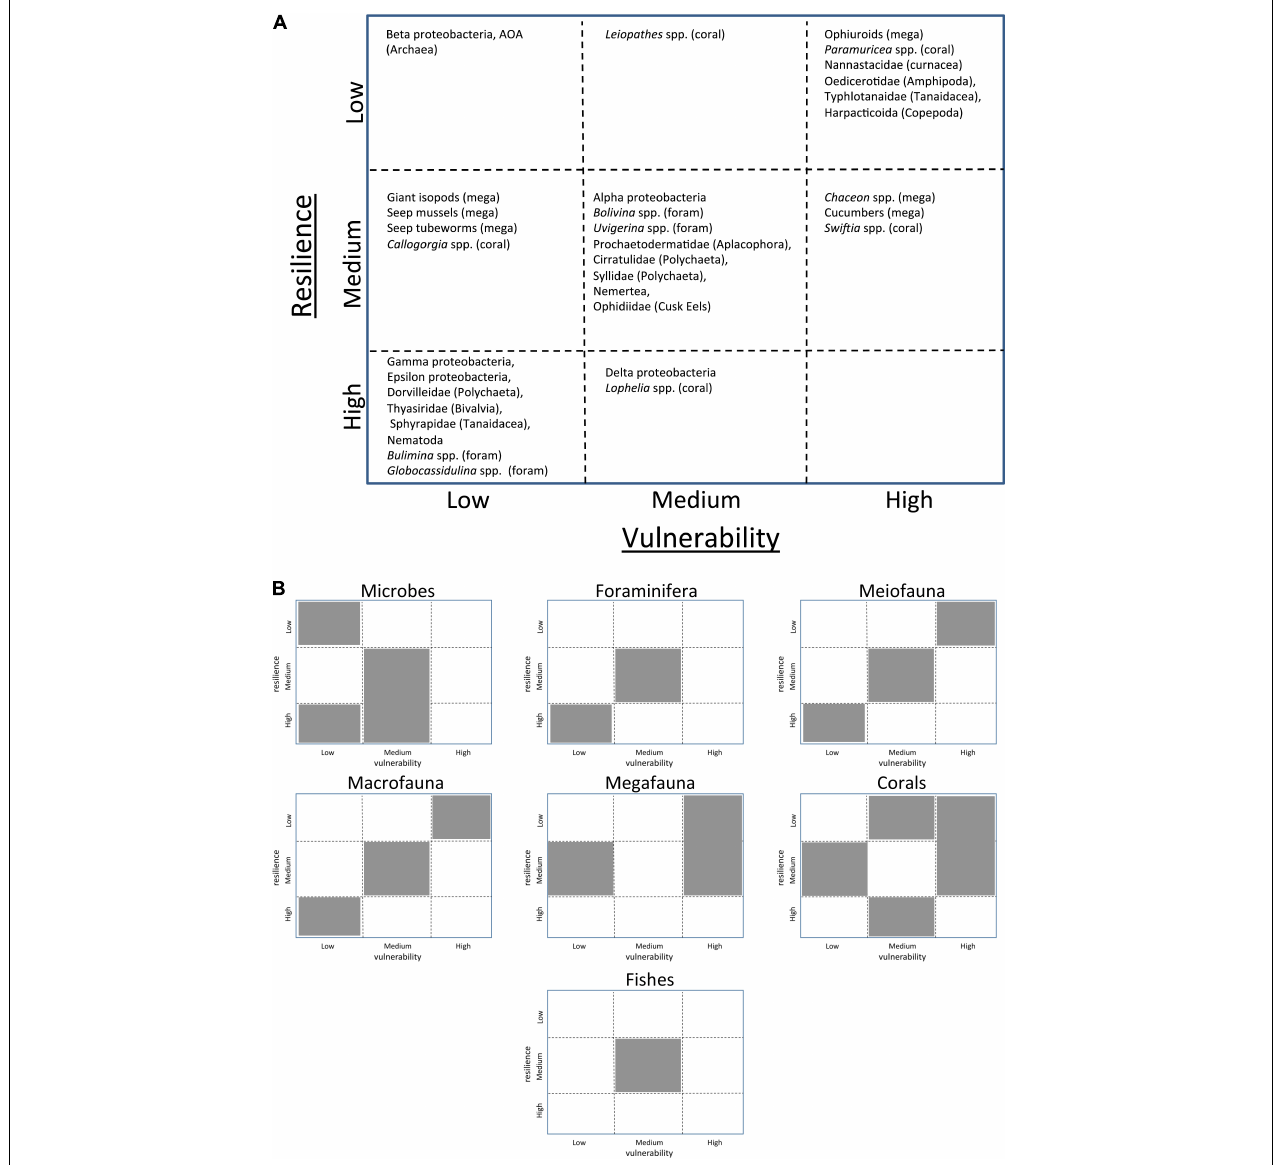
FIGURE 3 | The benthic ecotype Vulnerability-Resilience matrix (A) including designations for taxa within each group as high, medium or low vulnerability and resilience and a summary (B) of the benthic ecotype Vulnerability-Resilience matrix with gray polygons indicating the locations on the matrix where representative taxa from each group are located. A table of these designations and their associated references is provided in Supplementary Table 1